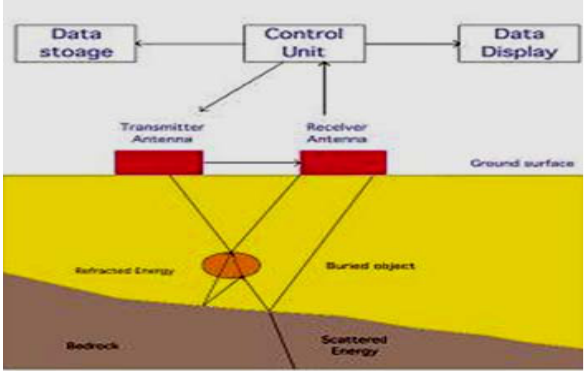
Figure 10. Principles of Operation of the